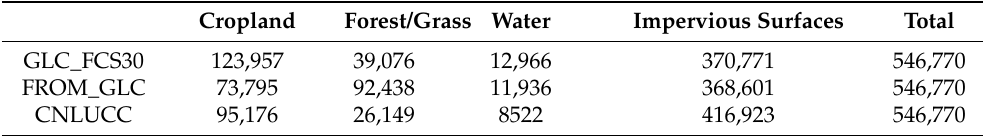
Figure 7. Classification System and results of reclassification. Table 5 shows the pixel numbers of four classification types in each dataset. Table 5. The number of pixels of four types.